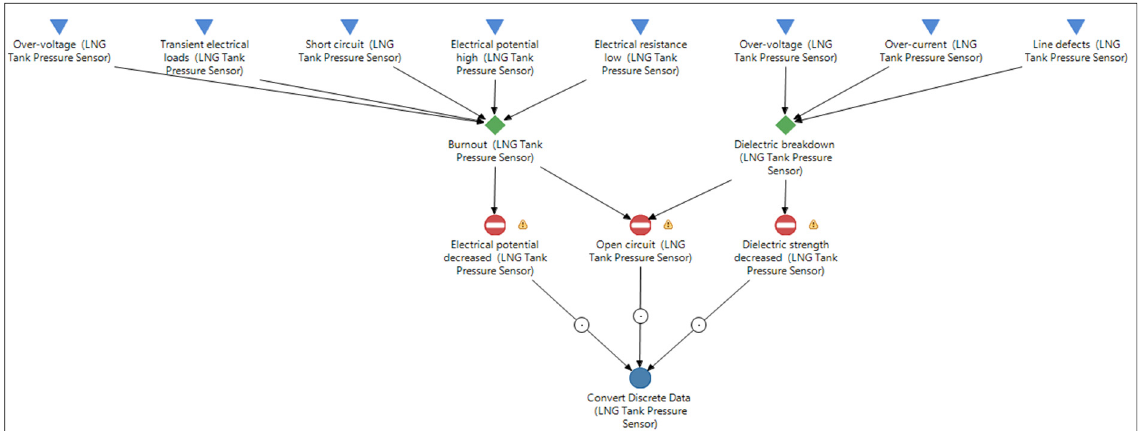
Figure 6. LNG tank pressure sensor failure diagram.